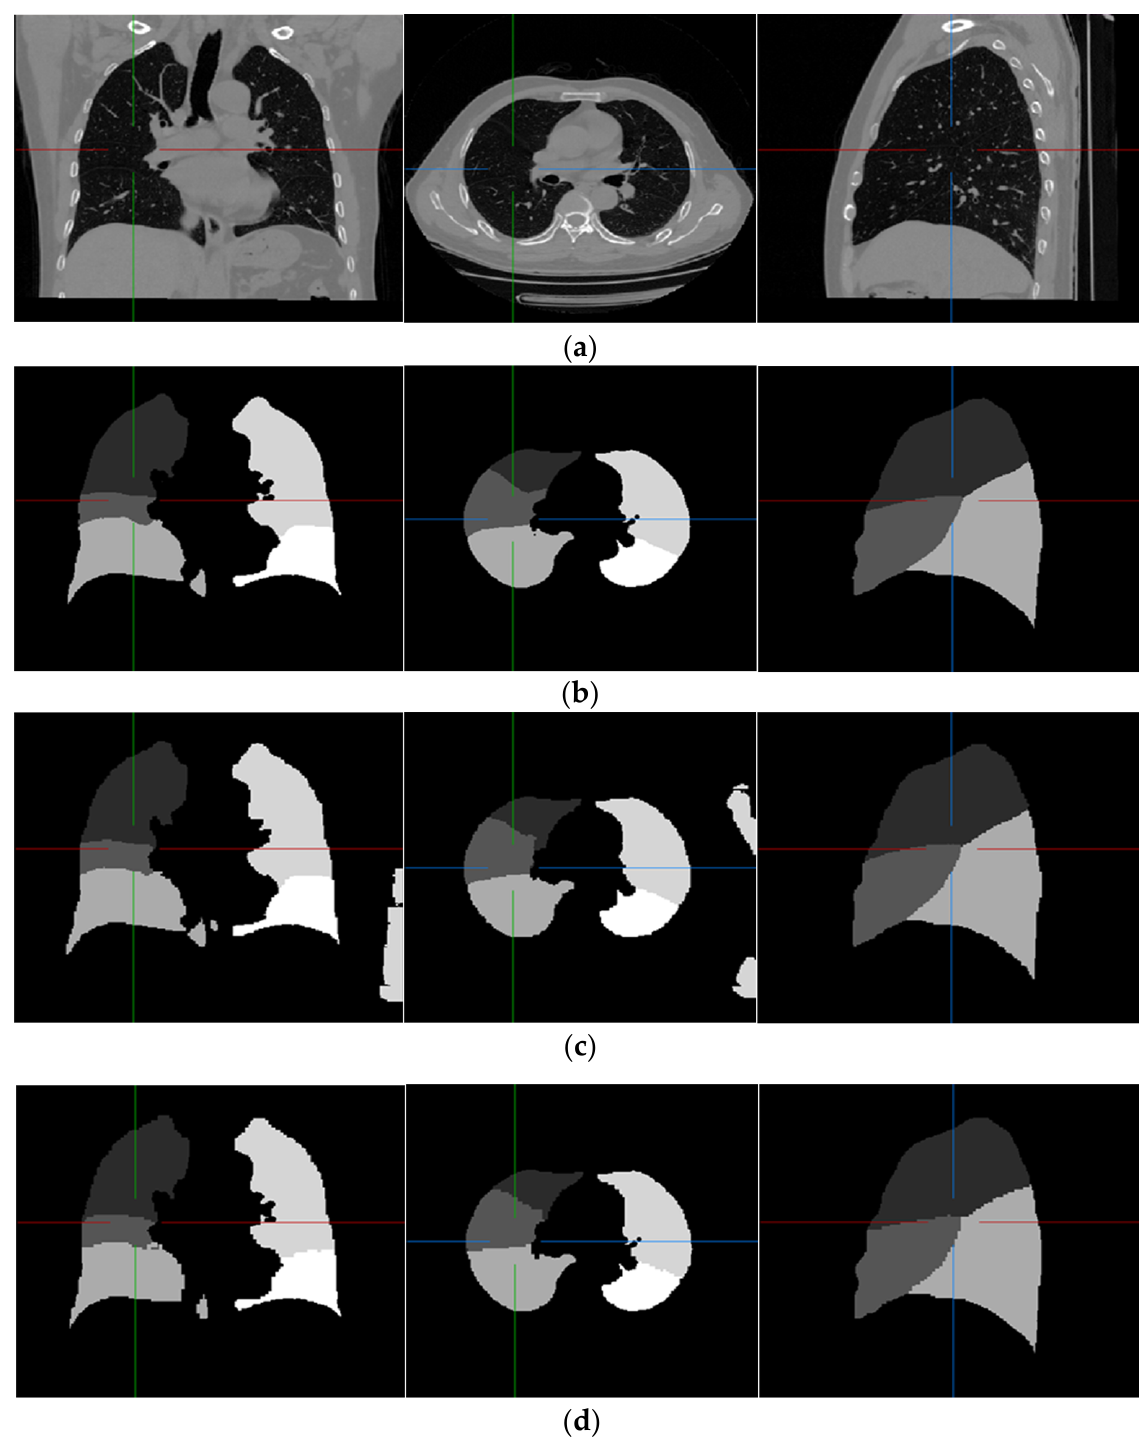
Figure 4. An example of the results of the experiment. ( a ) Original scan; ( b ) ground-truth; ( c ) FRV-Net; and ( d ) proposed method.